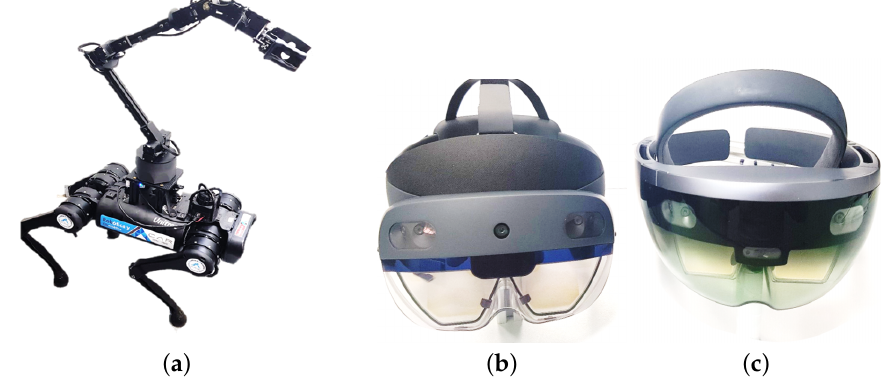
Figure 1. Materials used to validate the proof of concept. ( a ) Robotic set (ARTU-R + 6DoF Robot